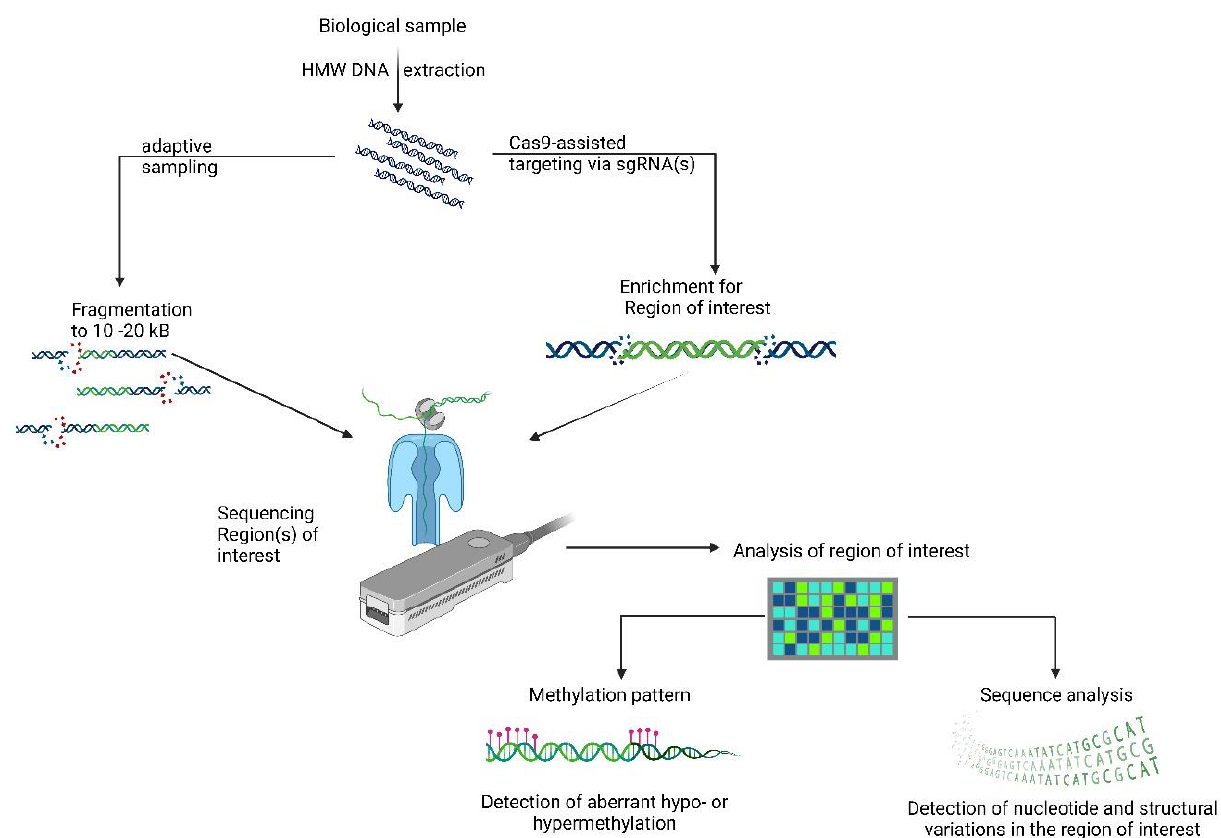
Figure 2. Principles of targeted nanopore sequencing: adaptive sampling and Cas9-assisted methods. High-molecular-weight DNA (HMW DNA) is extracted from relevant biological samples. After quality checking for concentration and purity, two highly potent methods can be applied for a targeted sequencing approach. The adaptive sampling approach can be used for selective enrichment of regions of interest to be sequenced. To enrich prior sequencing during library preparation with designed sgRNAs, the region(s) of interest can be selectively enriched and loaded to the nanopore-based sequencing platform. After quality control assessment, two pipelines can be run, one for methylation pattern analysis, and another for detection of nucleotide and structural variations. This highlights the unique power of nanopore sequencing: parallel detection of both sequence and methylation pattern. Created with BioRender.com. (accessed on 06 September 2022).